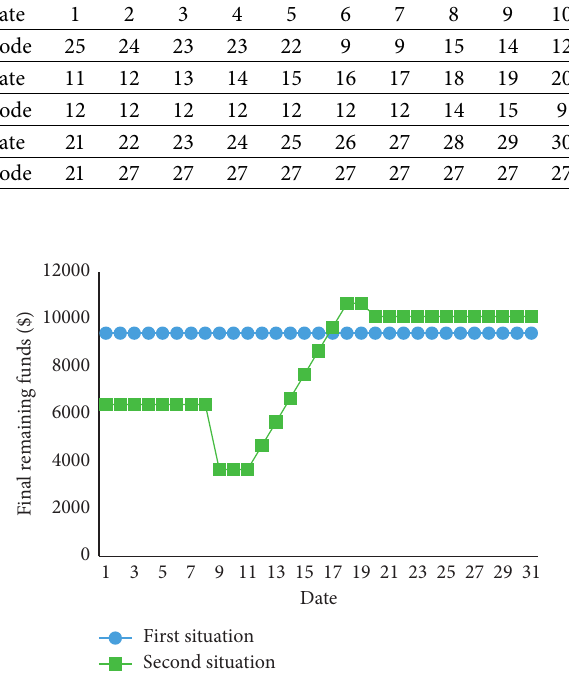
Figure 12: Comparison of final remaining funds in two situations in Level